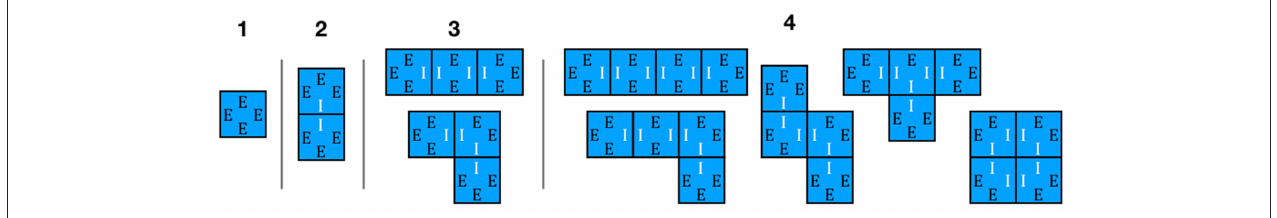
FIGURE 4 | Adjacency for small disturbances. Edges are labeled as (E)xterior and (I)interior. For size 1, there is 0 probability of self-adjacency (disturbed patches adjacent to other disturbed patches). For size 2 and 3 it is 1/4 and 1/3, respectively, while for size 4 the adjacency is either 1/2 (square configuration) or 3/8 (all other configurations).